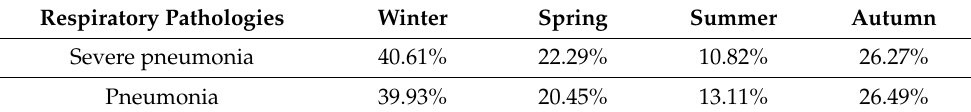
Table 6. Seasonal distribution of respiratory diseases in children under five years of age.